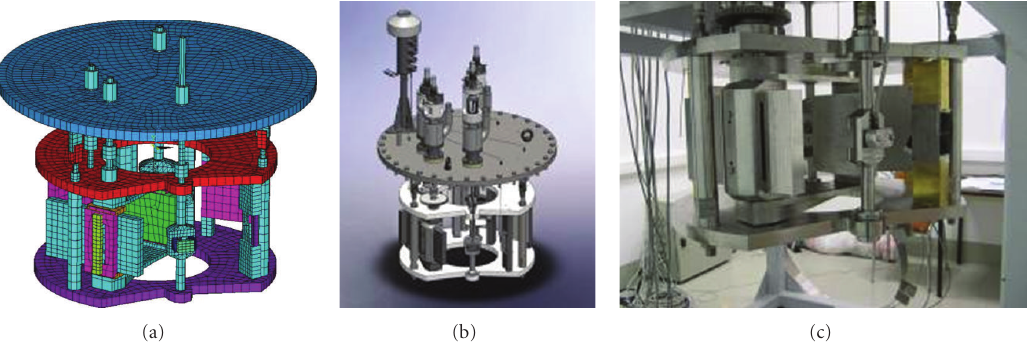
Figure 18: multireflector mockup (1m diameter) devoted to in sodium ultrasonic telemetry